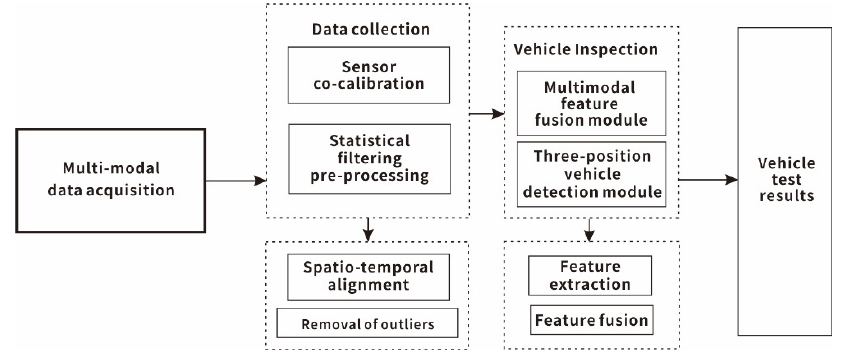
Figure 1. Framework of vehicle-detection algorithm.